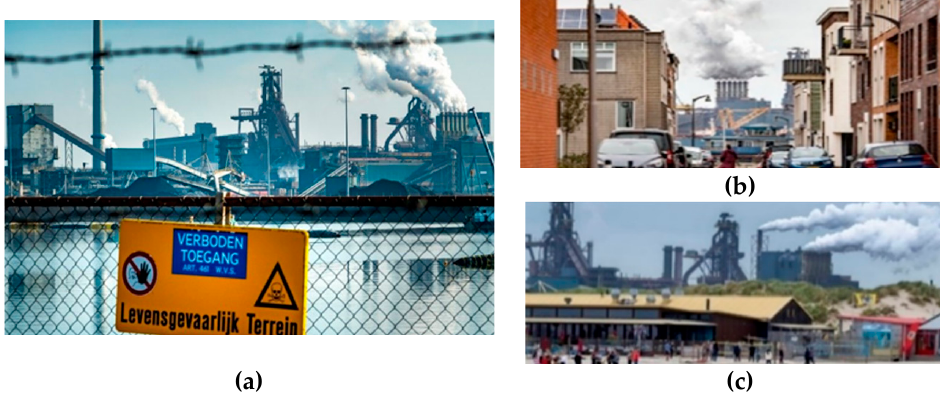
Figure 4. Views of the company: ( a ) TISCO Europe, Ijmuiden; ( b ) Wijk aan Zee view, city view and (c) Wijk aan Zee view, another city view (RTL News, 2 September 2021 and Broekhuijsen, 2021). Hence, TATA Ijmuiden, similar to the entire steel industry [167], continuously en- dangers its employees, who are also occupants of houses in the local neighbourhoods.